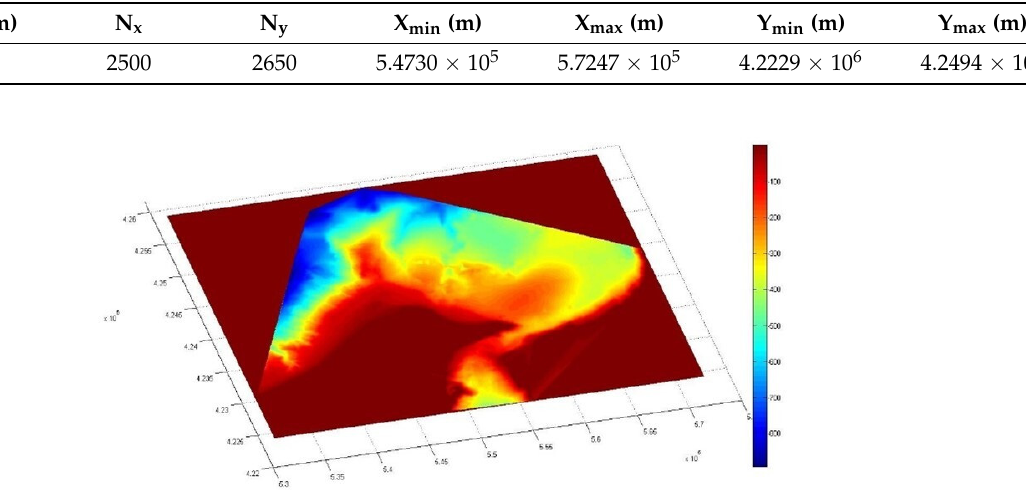
Table 1. Meshgrid features interpolating bathymetric data.